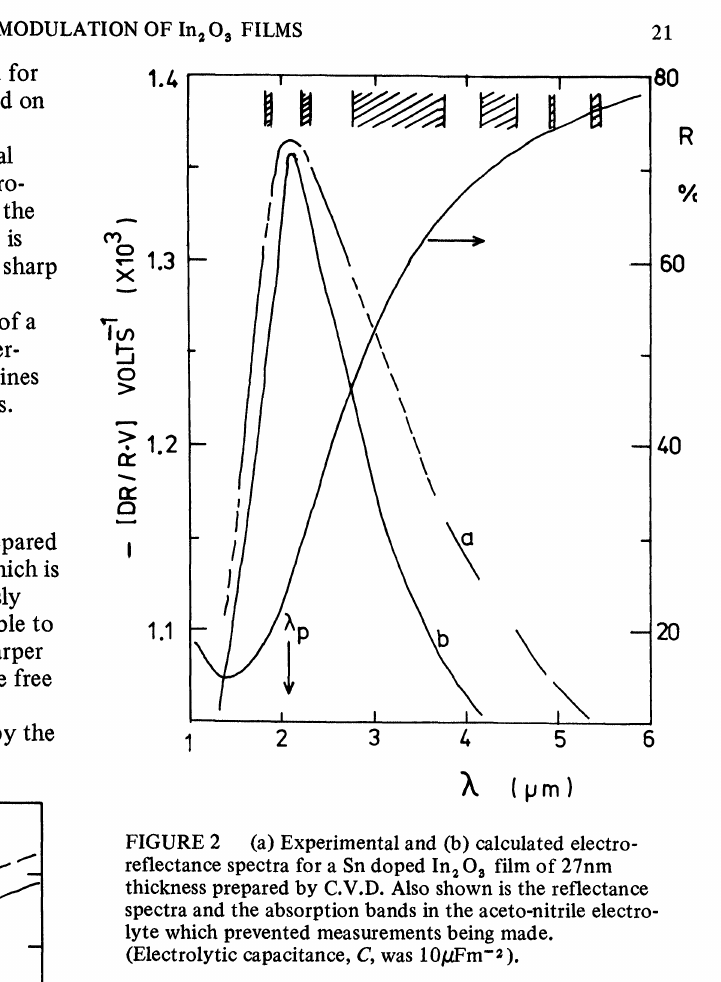
(a) Experimental and (b) calculated electro- reflectance spectra for a Sn doped Inz Oa film of 27nm thickness prepared by C.V.D. Also shown is the reflectance spectra and the absorption bands in the aceto-nitrile electro- lyte which prevented measurements being made. (Electrolytic capacitance, C, was 10/.tFm-2